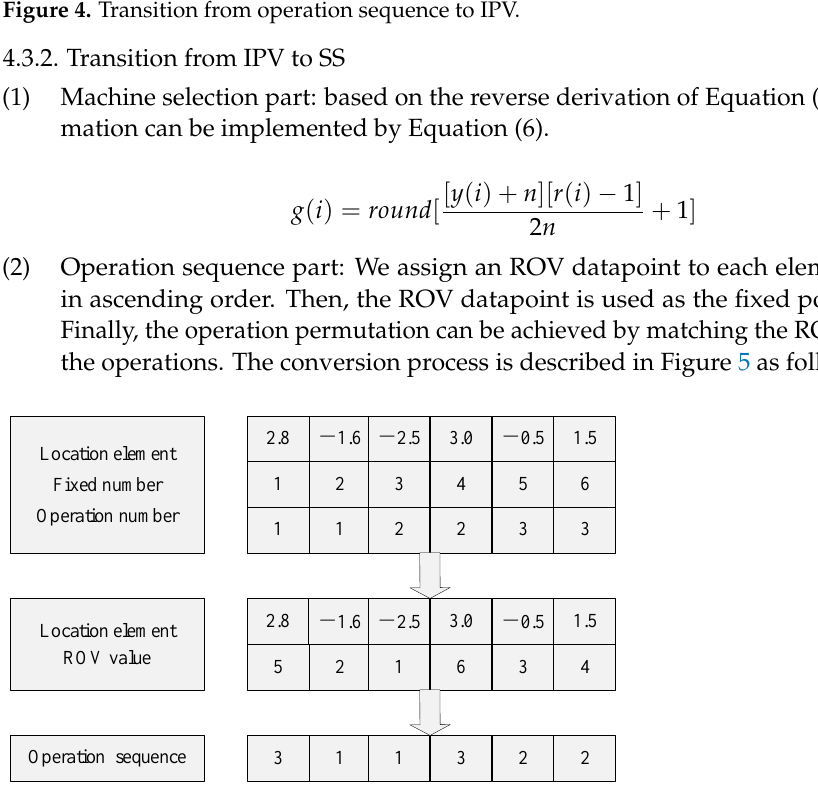
Figure 5. Transition from IPV to operation sequence.